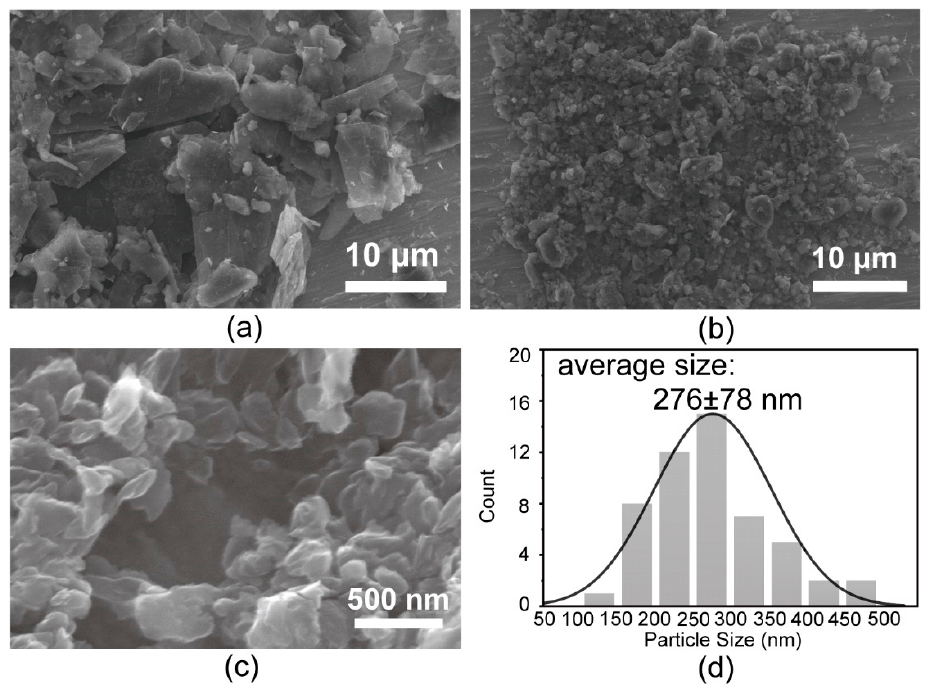
Figure 3. Characterization on the morphology and statistical analysis of particle size. ( a ) SEM image of pristine graphite flakes. ( b , c ) SEM images of NG-3 powder. ( d ) Gaussian curve approximation of particle-size-distribution plot based on the statistical counting of NG-3 particles appearing in ( c ).